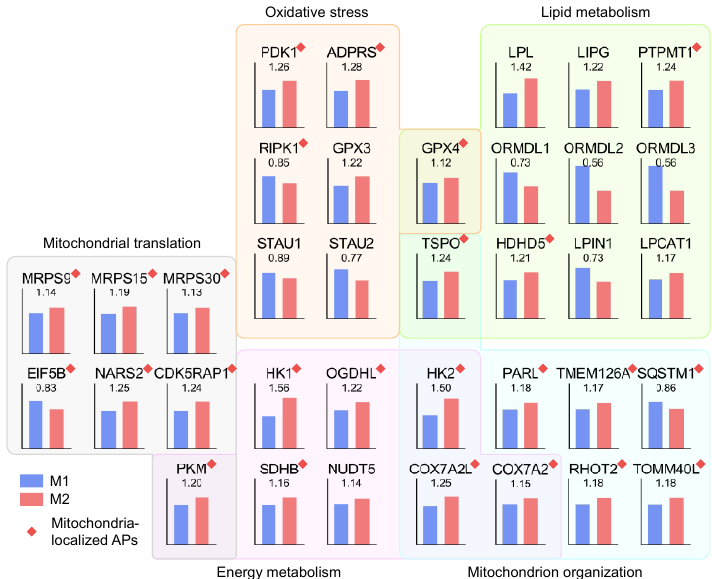
Figure 7. Normalized intensities and inter-group ratios of 36 APs in the five selected functional cat-